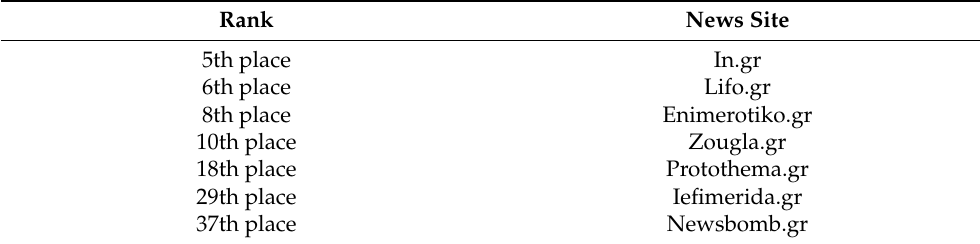
Table 1. News sites ranking (according to Alexa ranking 3 December